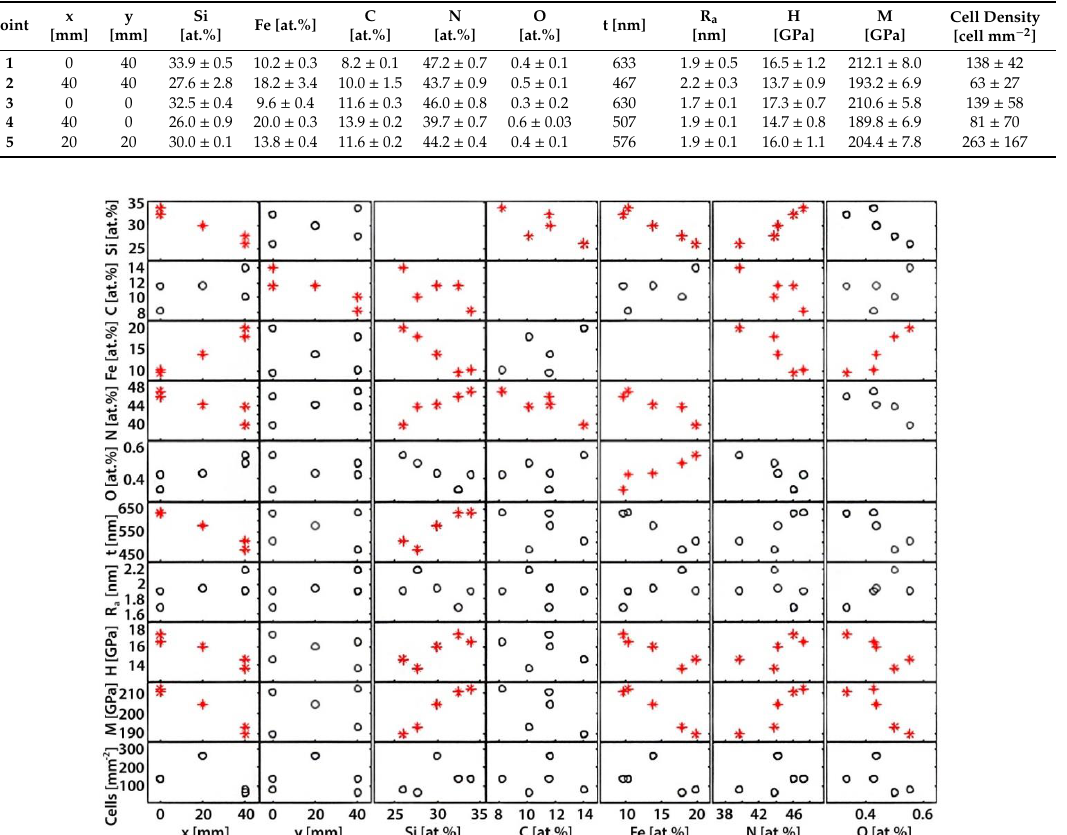
Figure 2. An overview of the various input and output parameters and their correlations. Each rectangle represents a graph where the input parameters are found on the x-axis and the output on the y-axis. Please note that the compositional elements (Si, C, Fe, N and O) are both output and input parameters as they vary as a function of the coordinates (x and y) and are important to consider as input parameters for the thickness, surface roughness (R a ), mechanical properties (H and M), and cell density. Cases where there was a statistically significant correlation were marked with red stars rather than black circles.